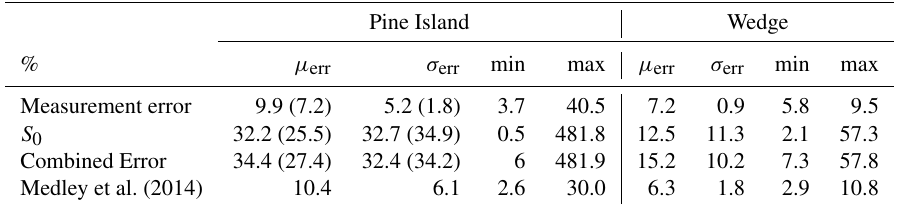
Table 5. Mean ( µ err ), standard deviation ( σ err ), minimum, and maximum gridded SMB errors with respect to basin-wide hybrid ASIRAS– RACMO SMB estimates. Mean and σ values in brackets are limited to the 190km practical range threshold and weighted according to the ASIRAS partitioning in Fig.